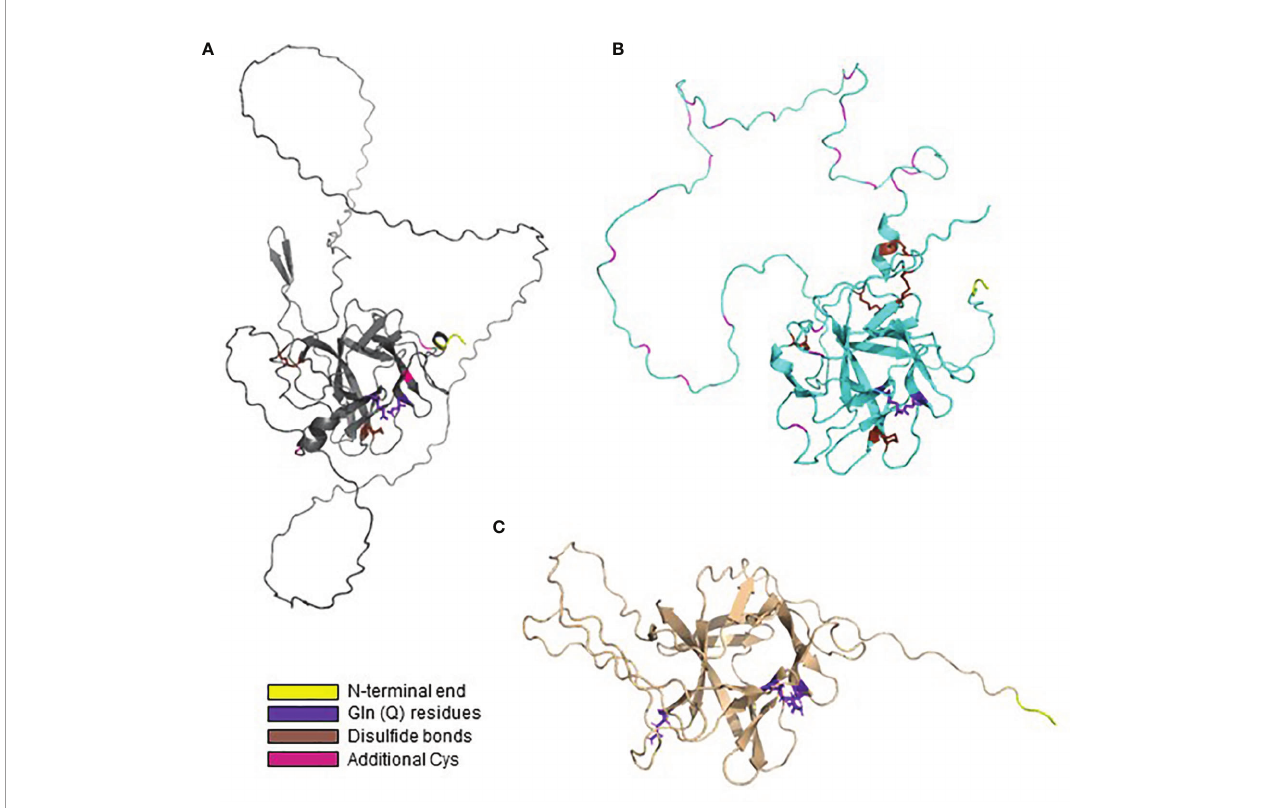
FIGURE 8 | AlphaFold structural predictions for representative proteins that vary from the S. cerevisiae model protein sequences. In each image, Gln residues are highlighted in purple, Cys in predicted disul fi de bonds marked in brown and other Cys highlighted in magenta. N-terminal amino acids are highlighted in yellow. (A) AlphaFold predicted structure for Co0A08050, representative of CGOB Group B sequences. (B) Predicted structure for the Cys-rich CaCis310 (Csp1). (C) Predicted structure for CmPir21, which did not have any Cys